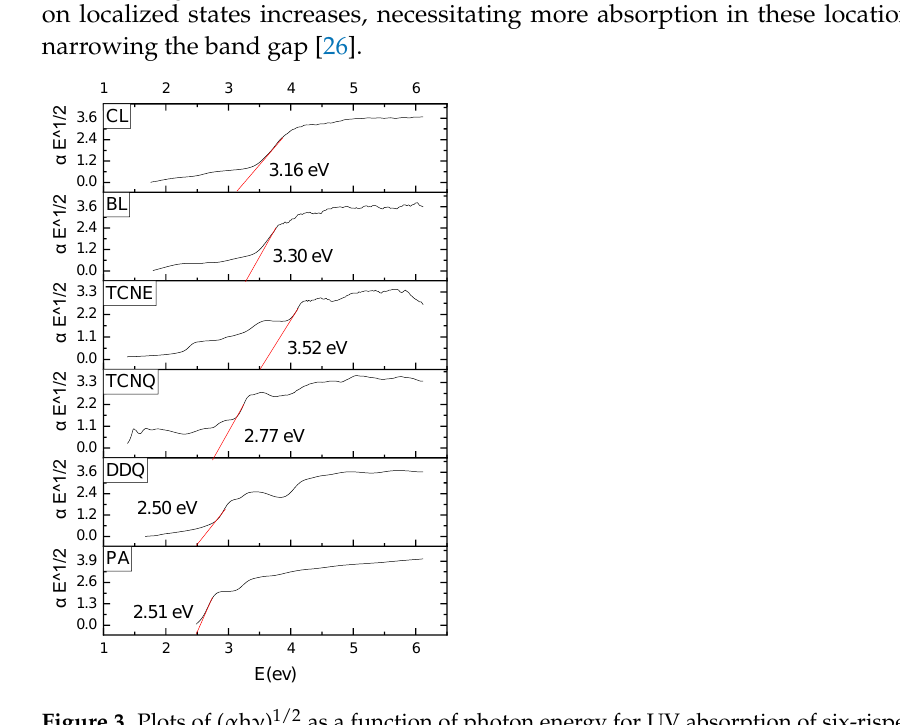
Figure 3. Plots of ( α h ν ) 1/2 as a function of photon energy for UV absorption of six-risperidone solid charge transfer complexes.